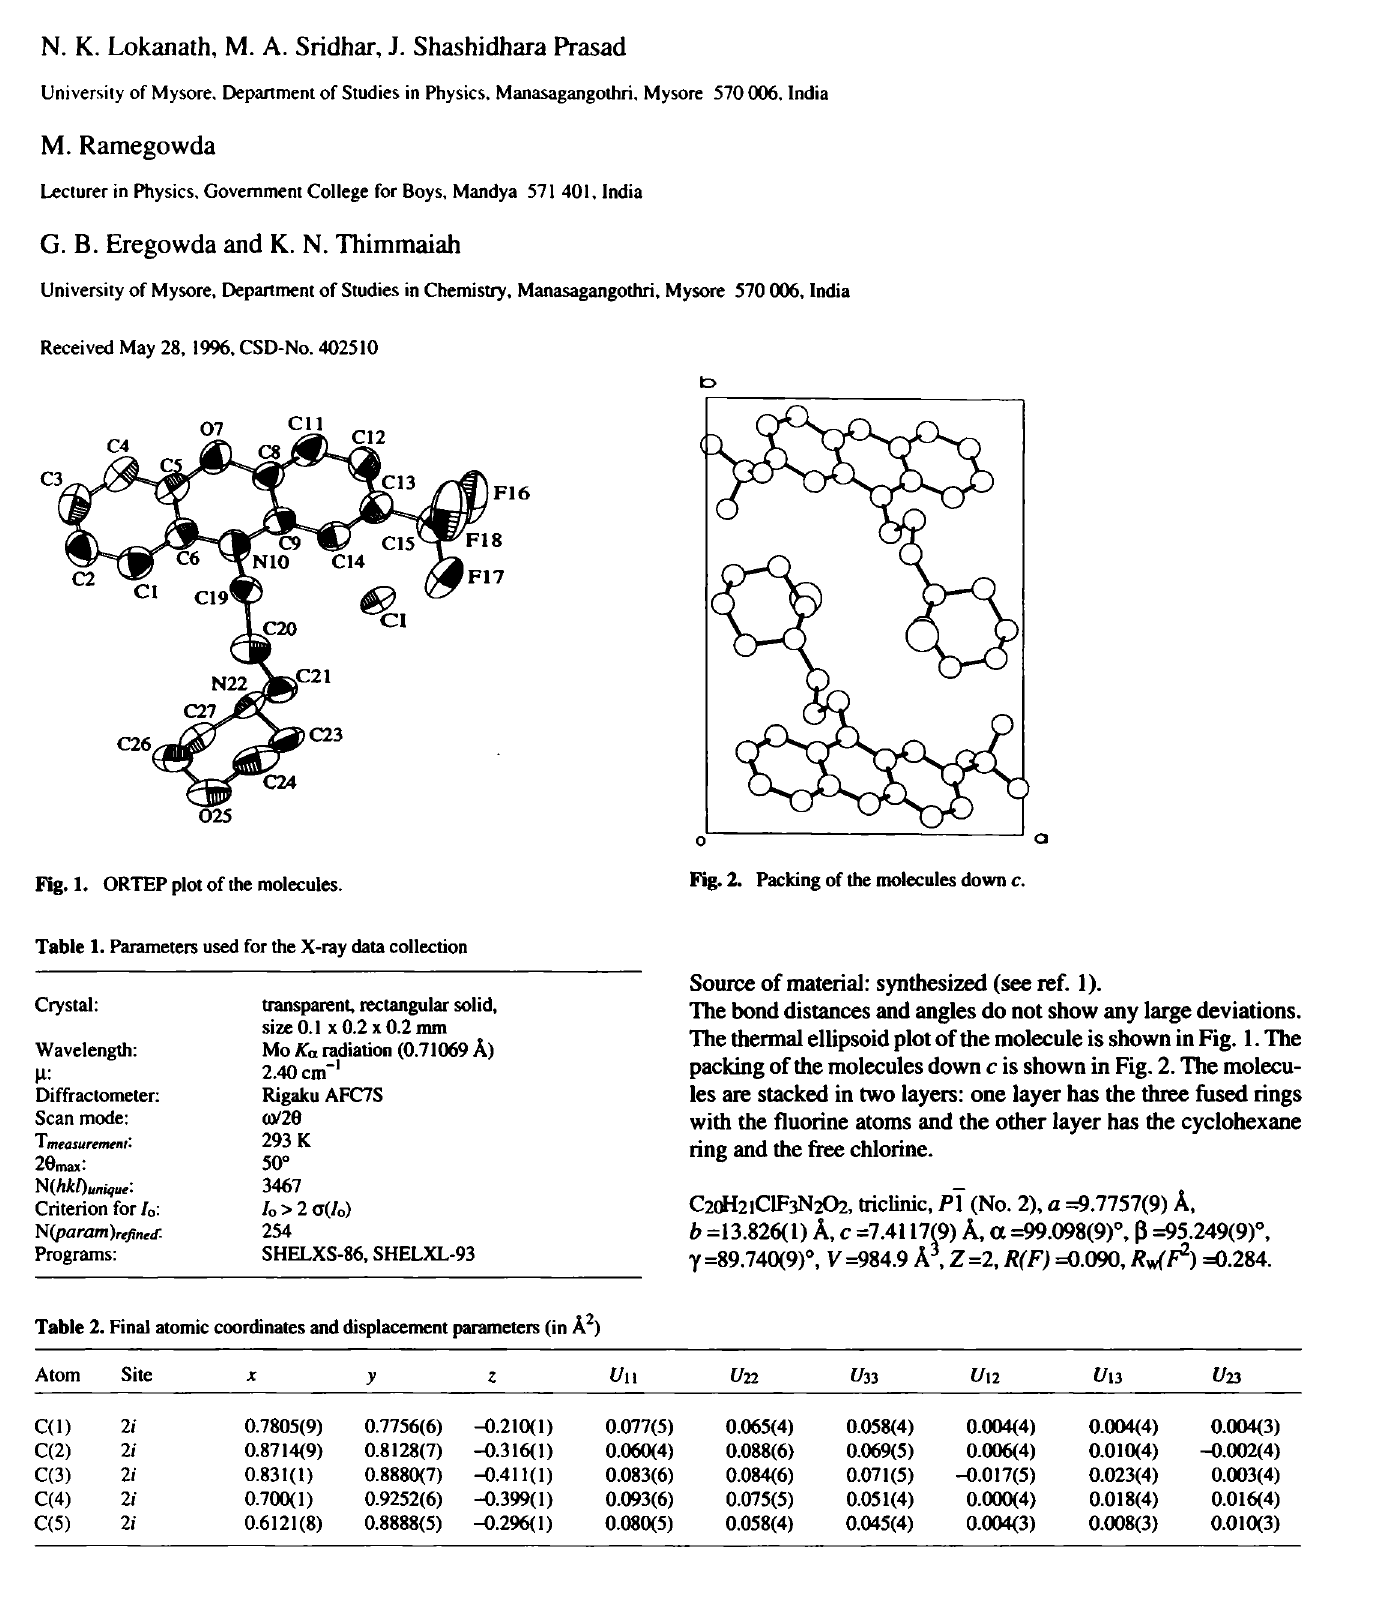
Table 1. Parameters used for the X-ray data collection